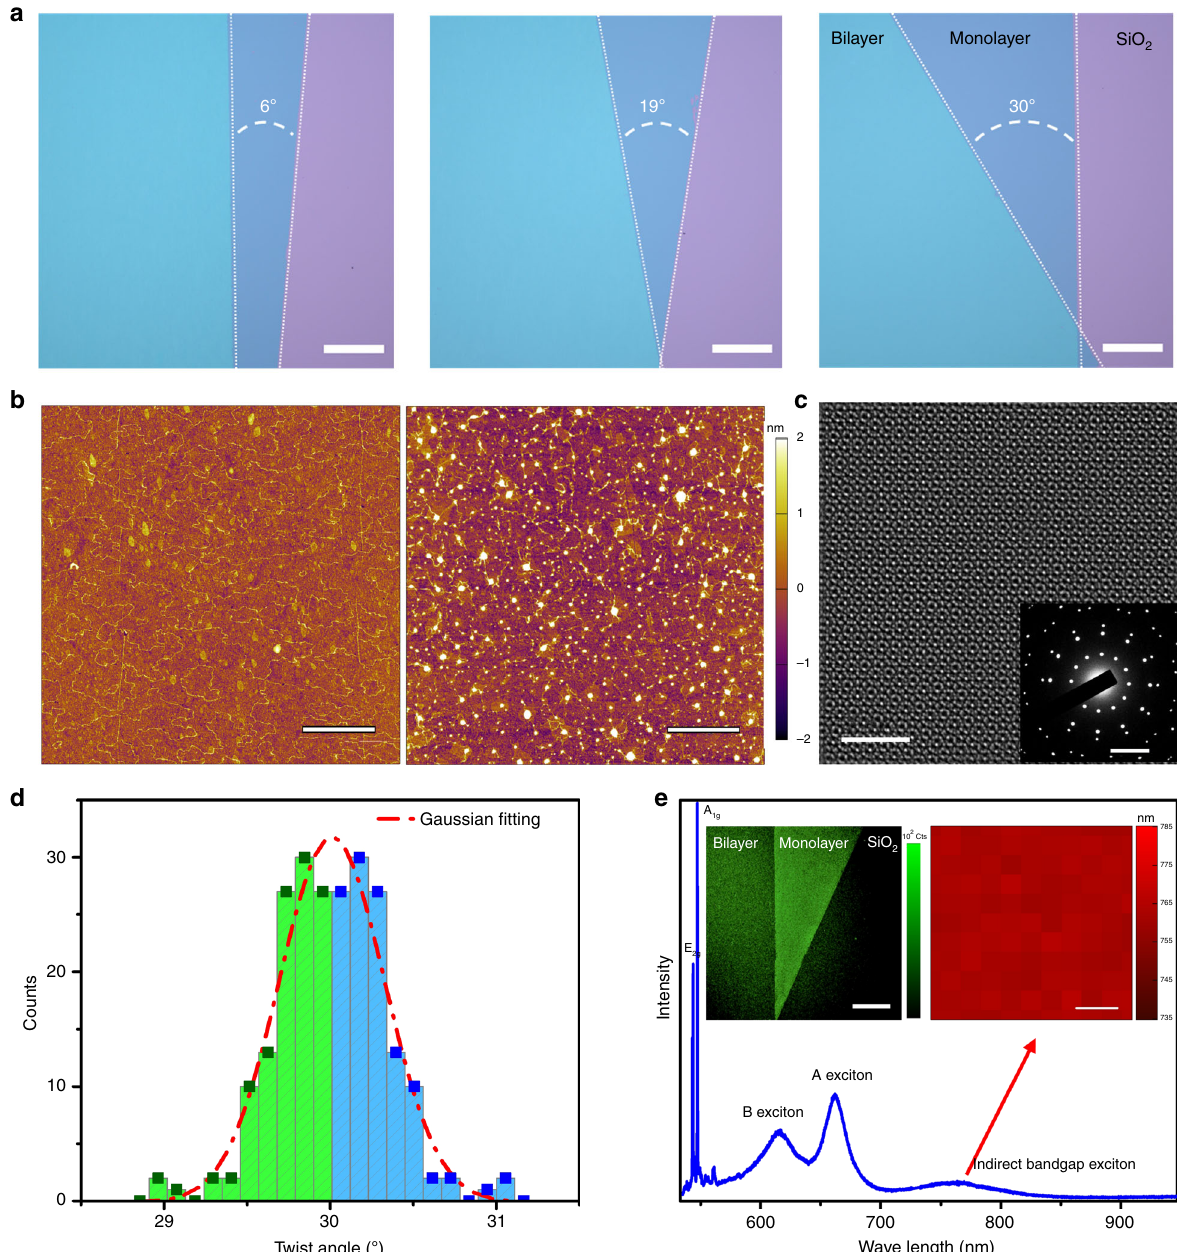
Fig. 2 High-quality twisted bilayer MoS 2 fi lms. a Optical Images of three typical transferred twisted bilayer MoS 2 fi lms on Si substrates with 300 nm SiO 2 : 6°, 19°, and 30°, scale bar 300 μ m. b AFM images of the transferred monolayer (left) and 30° bilayer (right) MoS 2 fi lms, scale bar 2 μ m. c STEM image after FFT fi ltering of 30° stacked bilayer MoS 2 fi lm, scale bar 3 nm; insert is electron diffraction pattern of 30° stacked bilayer MoS 2 fi lm, scale bar 5 nm − 1 . d Twist angle distribution of eight different 30° stacked bilayer MoS 2 fi lm samples, red dash line is the Gaussian fi tting. Blue region is just a copy of the green region, to make the chart symmetric. e PL spectrum of 30° stacked bilayer MoS 2 fi lm. Left inset in e is the laser scanning confocal fl uorescence microscopy image, scale bar 300 μ m; the right inset is a 100 × 100 μ m 2 mapping of the indirect bandgap position, scale bar 20 μ m. Source data are provided as a Source Data fi